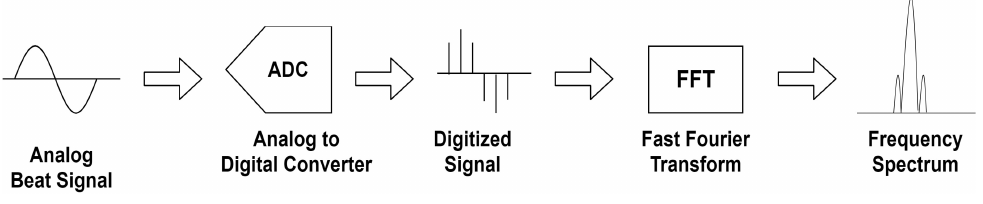
Figure 8. Signal processing